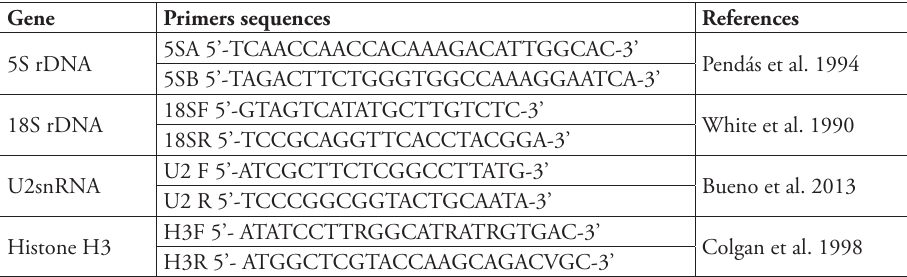
Table 1. Primers used to PCR amplification for gene fragments 5S rDNA, 18S rDNA, U2 snRNA and Histone